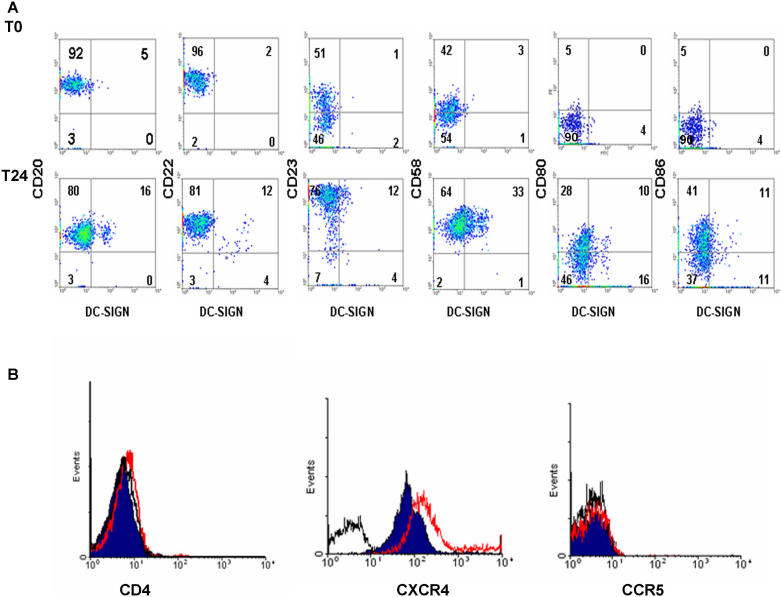
Coexpression of DC-SIGN and Markers of Activation on B CellsExpression of CD20, CD22, CD23, CD58, CD80, and CD86 in purified, unstimulated ([A] time 0 h; T0) and IL-4– and CD40L-stimulated ([B] time 24 h; T24) B cells. The quadrants were set on the isotype controls. Expression of CD4, CXCR4, and CCR5 is shown for unstimulated (full histograms) and stimulated (24 h; red profile histograms), purified B lymphocytes. Isotype controls are indicated by gray lines. Data are from a single experiment representative of five independent experiments.